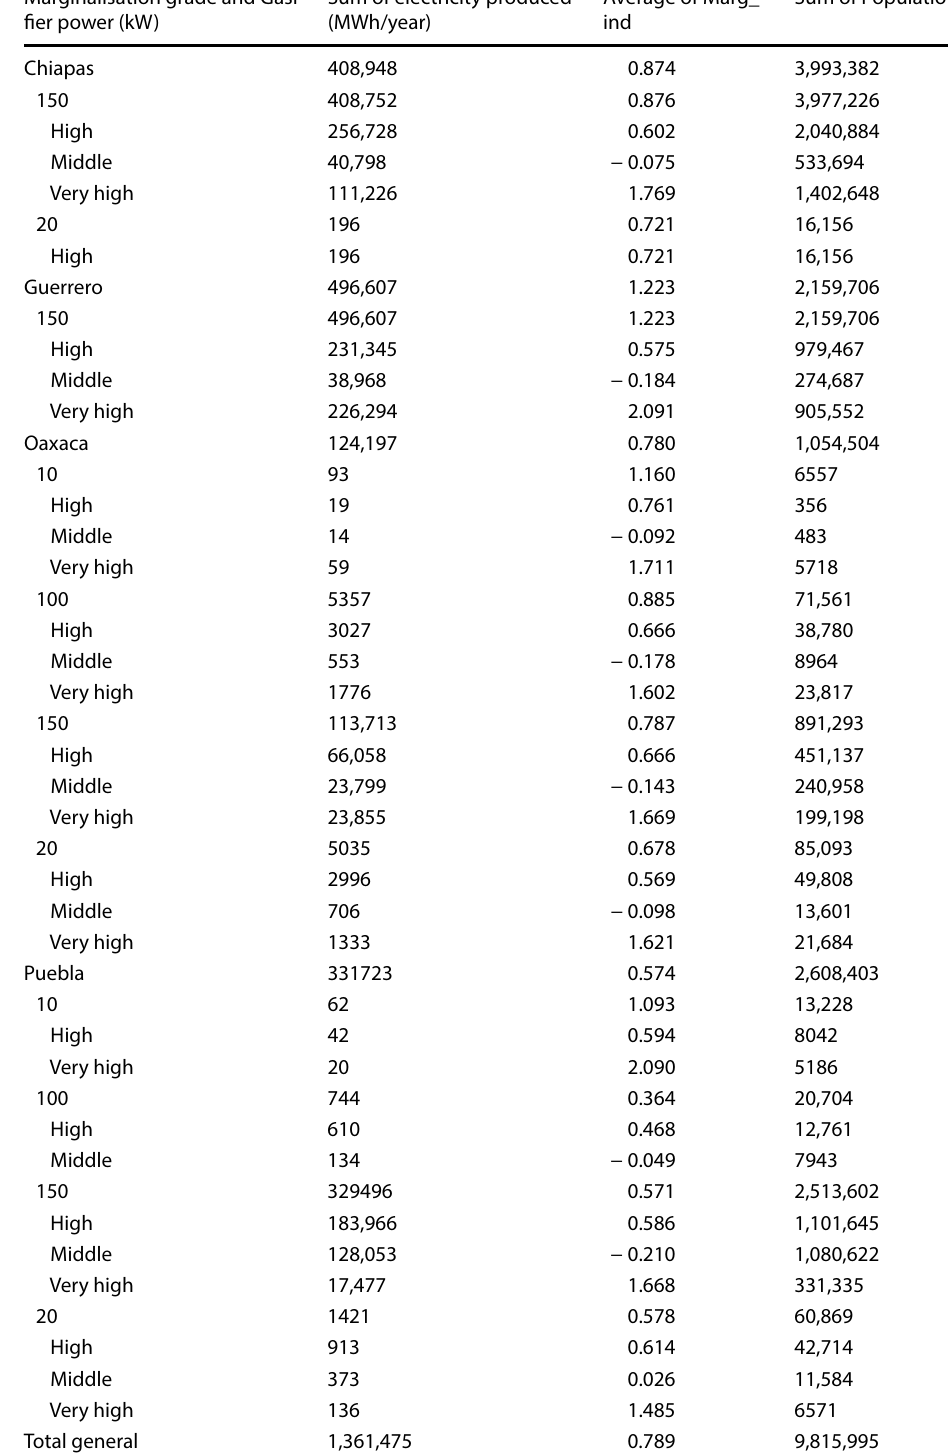
Table 7 Marginalisation grade and Gasifier power for four states. Including electricity produced and